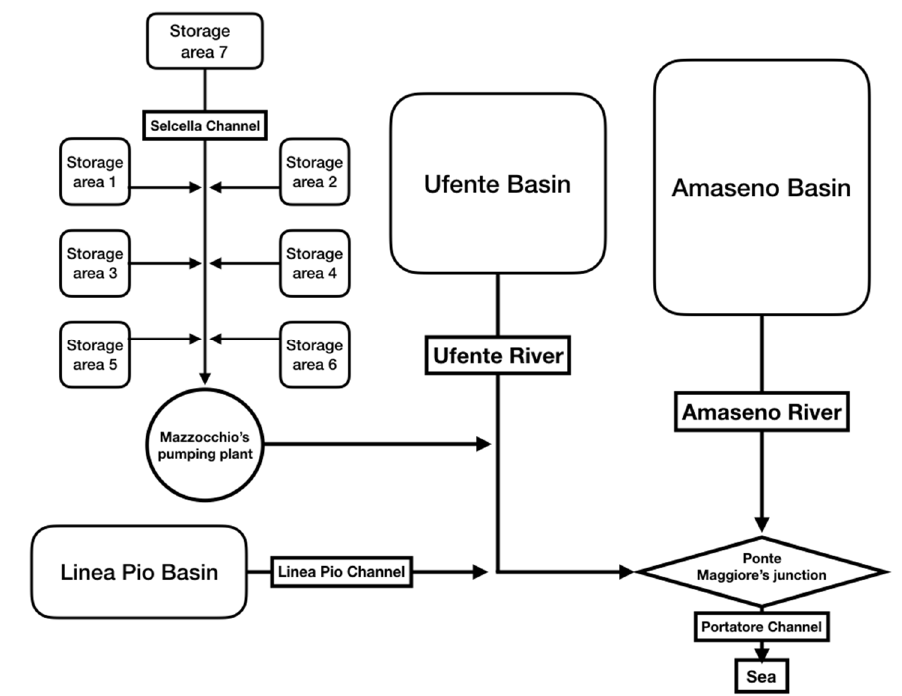
Figure 5. Sketch of hydraulic model.